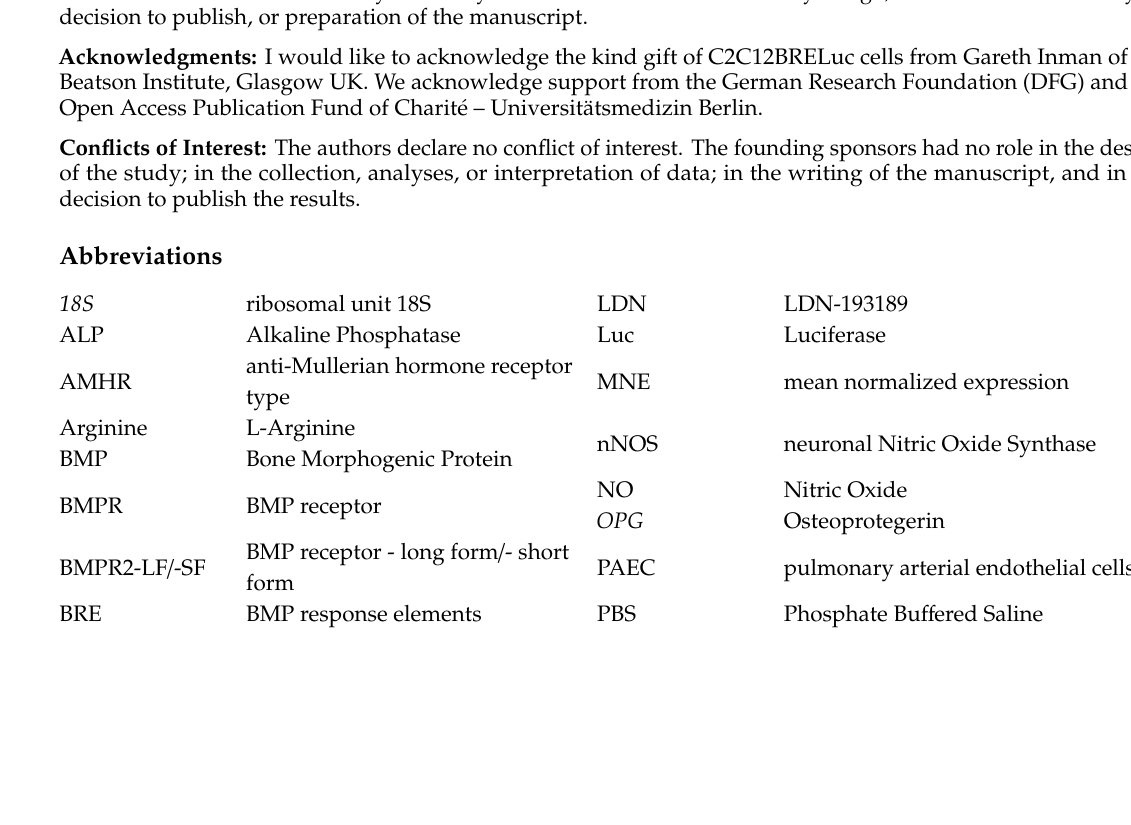
Figure S1: Supplementary figure for melting curves of